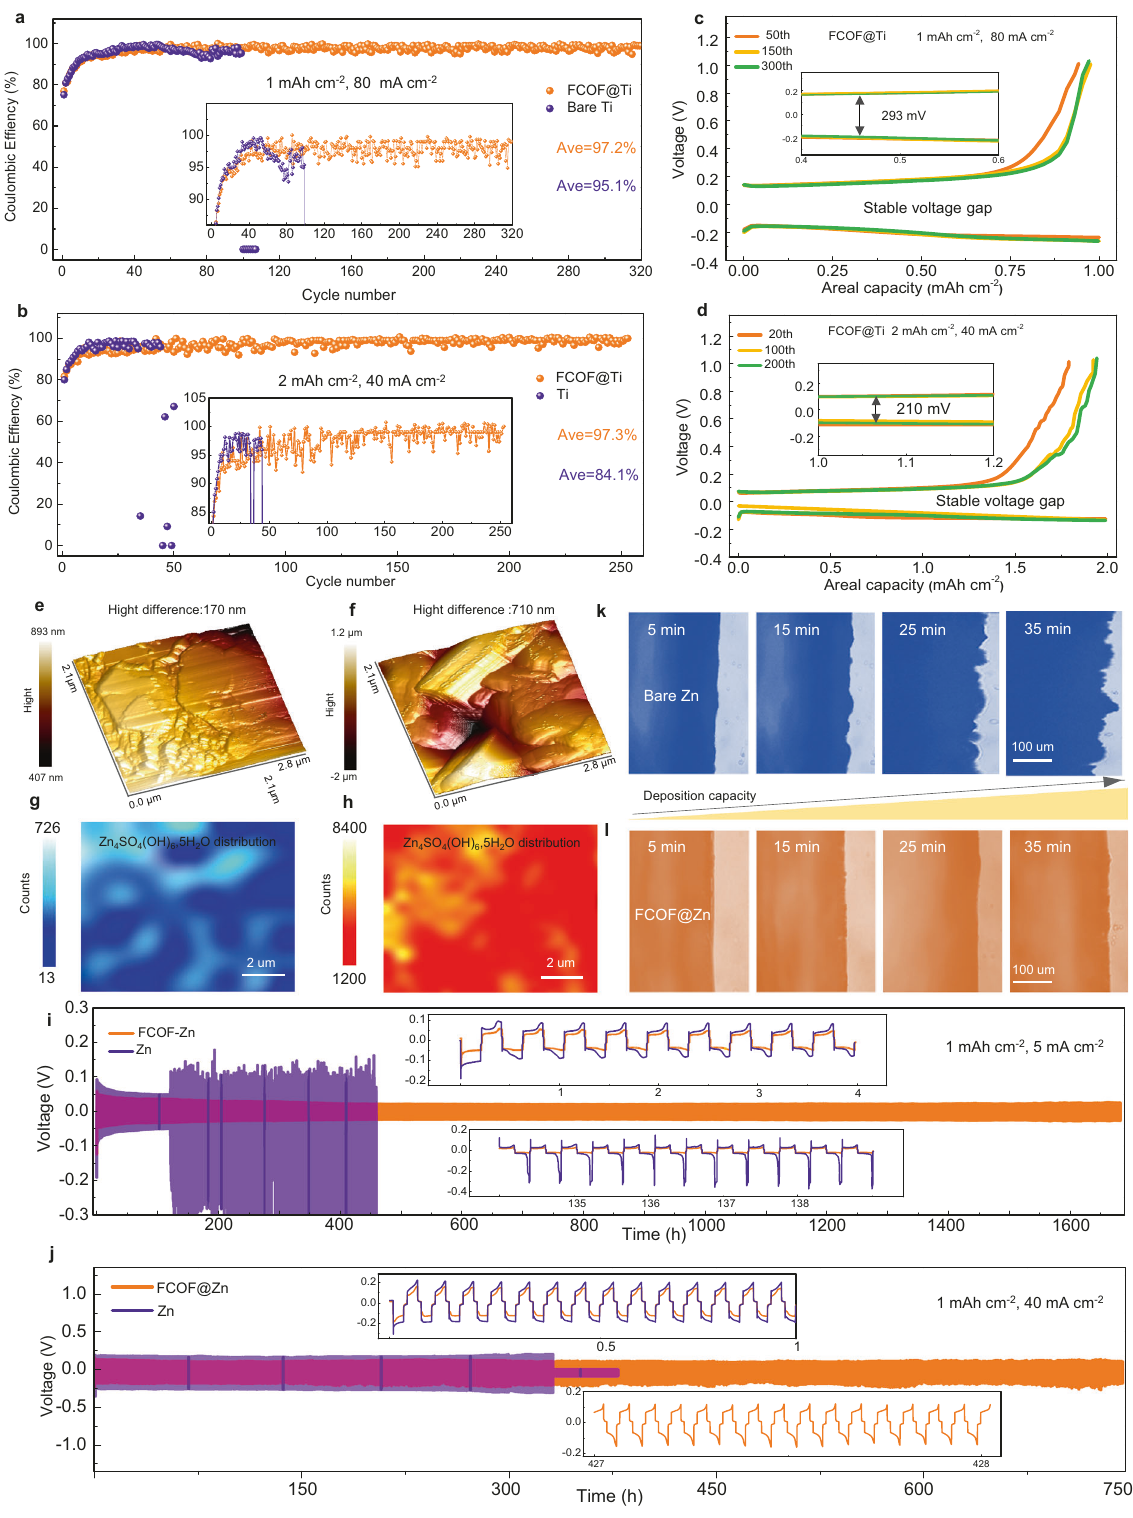
Fig. 4 The electrochemical performance of Zn anodes. CE of Zn plating/stripping on FCOF fi lm-coated Ti and bare Ti at a 1 mAh cm − 2 , 80 mA cm − 2 and b 2 mAh cm − 2 , 40 mA cm − 2 . c , d The corresponding voltage pro fi les at various cycles on FCOF fi lm-coated Ti. The insets are enlarged voltage pro fi les. AFM 3D height imaging and 2D Raman mapping on the surfaces of Zn deposits after 200 cycles plating/stripping (1 mAh cm − 2 , 5 mA cm − 2 ), e , g on FCOF fi lm-coated Ti and f , h bare Ti. Cycling performance of Zn symmetric cells with or without FCOF fi lm protection at i 1 mAh cm − 2 , 5 mA cm − 2 , and j 1 mAh cm − 2 , 40 mA cm − 2 . The insets are initial and selected voltage-time pro fi les. In situ optical microscopy studies on Zn deposition behaviors. k Bare